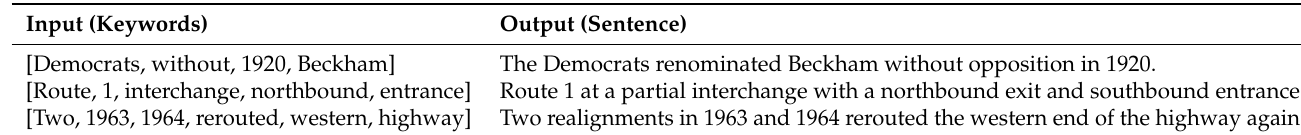
Table 1. Input and output for the pre-training phase. Keywords are extracted from a sentence.